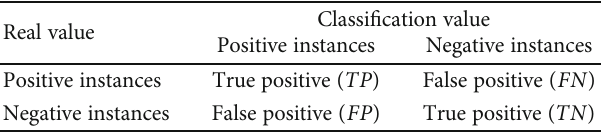
Table 1: Confusion matrix.